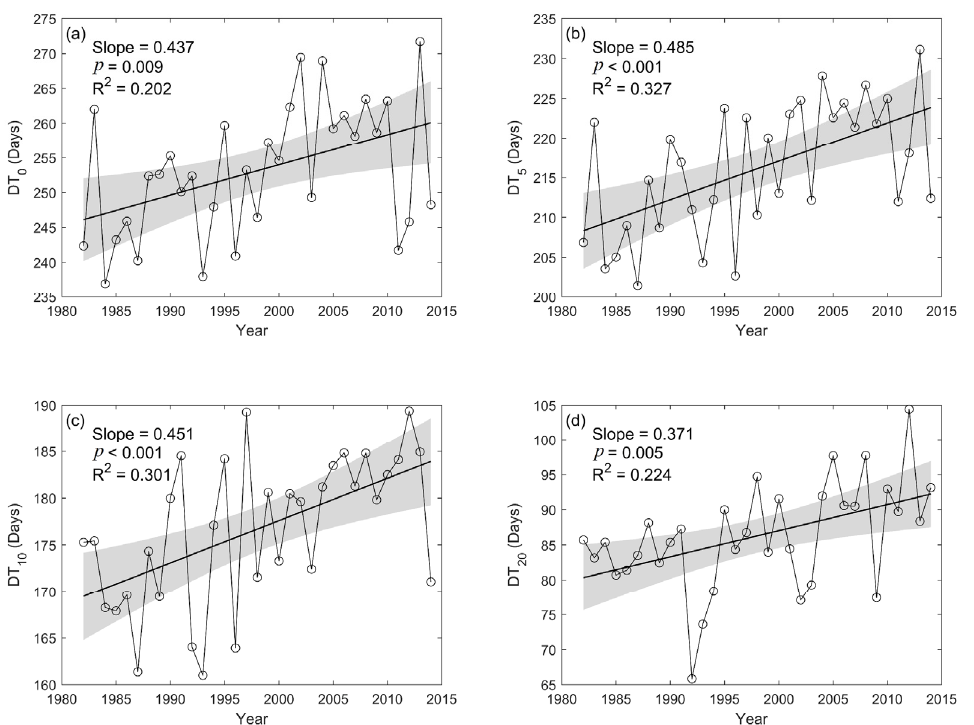
Figure 5. Interannual variations in ( a ) DT 0 , ( b ) DT 5 , ( c ) DT 10 , and ( d ) DT 20 at a regional scale in the GLRCA during the period 1982–2014.